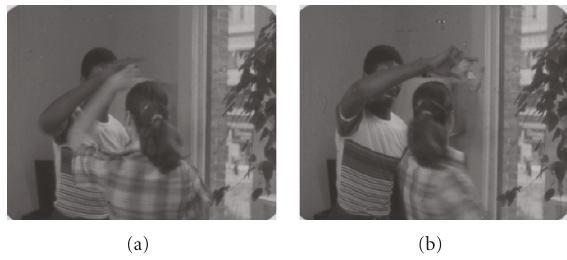
Figure 6: The “dance” sequence is the first of the ground truth sequences. The movement of the dancer in the foreground is patho- logical. Its motion is self-occluding which also causes occlusion and uncovering of the background.